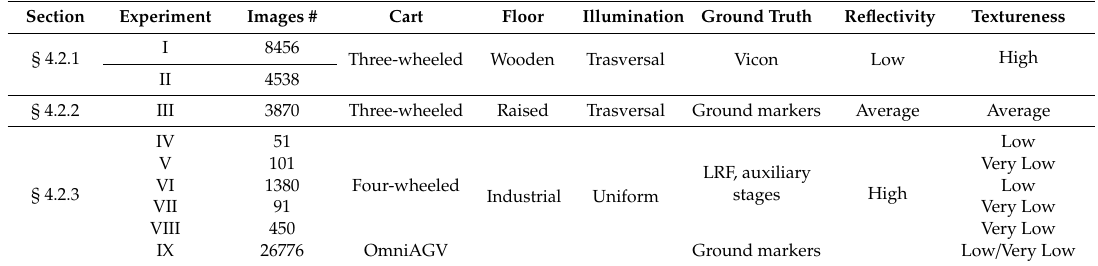
Table 1. Classification of the experiments according to the floor typology.